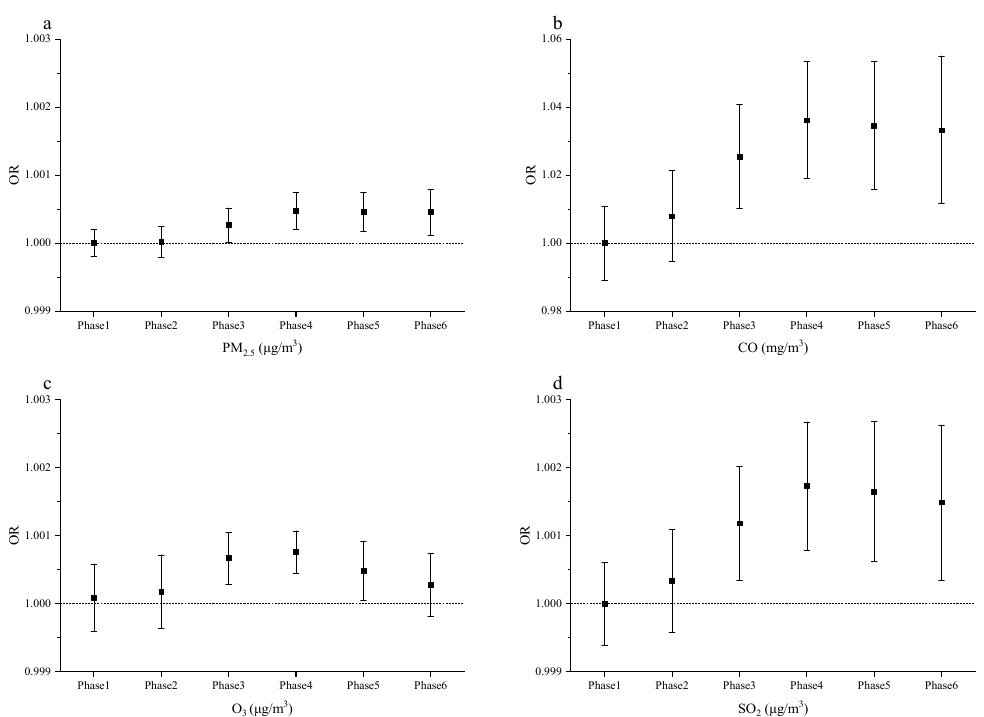
Figure 2. The relationship between the concentrations of four air pollutants and the gynecological cancer in six exposure phases. ( a ) The OR and 95% CI of gynecological cancer with a 1.0 µ g/m 3 increase in PM 2.5 concentration; ( b ) the OR and 95% CI of gynecological cancer with a 1.0-mg/m 3 increase in CO concentration; ( c ) the OR and 95% CI of gynecological cancer with a 1.0- μ g/m 3 increase in O 3 concentration; ( d ) the OR and 95% CI of gynecological cancer with a 1.0- μ g/m 3 increase in SO 2 concentration.